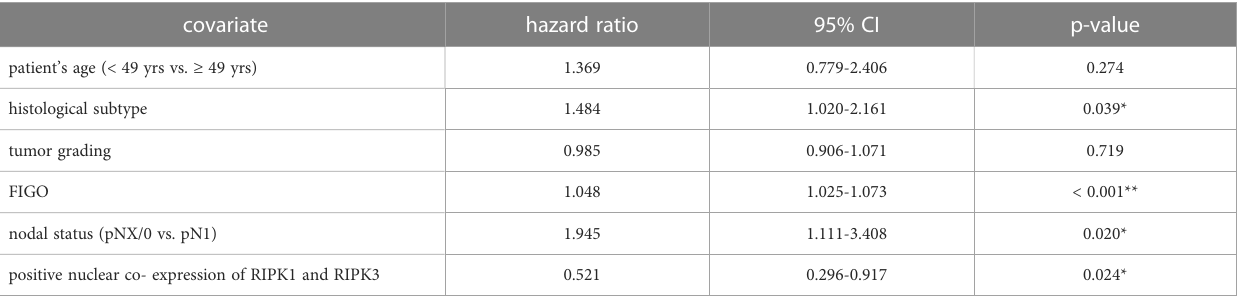
TABLE 7 Multivariate Cox regression analysis of cervical cancer patients ( n = 250) and their clinical and pathological characteristics including nuclear RIPK1-RIPK3 co-expression regarding PFS.